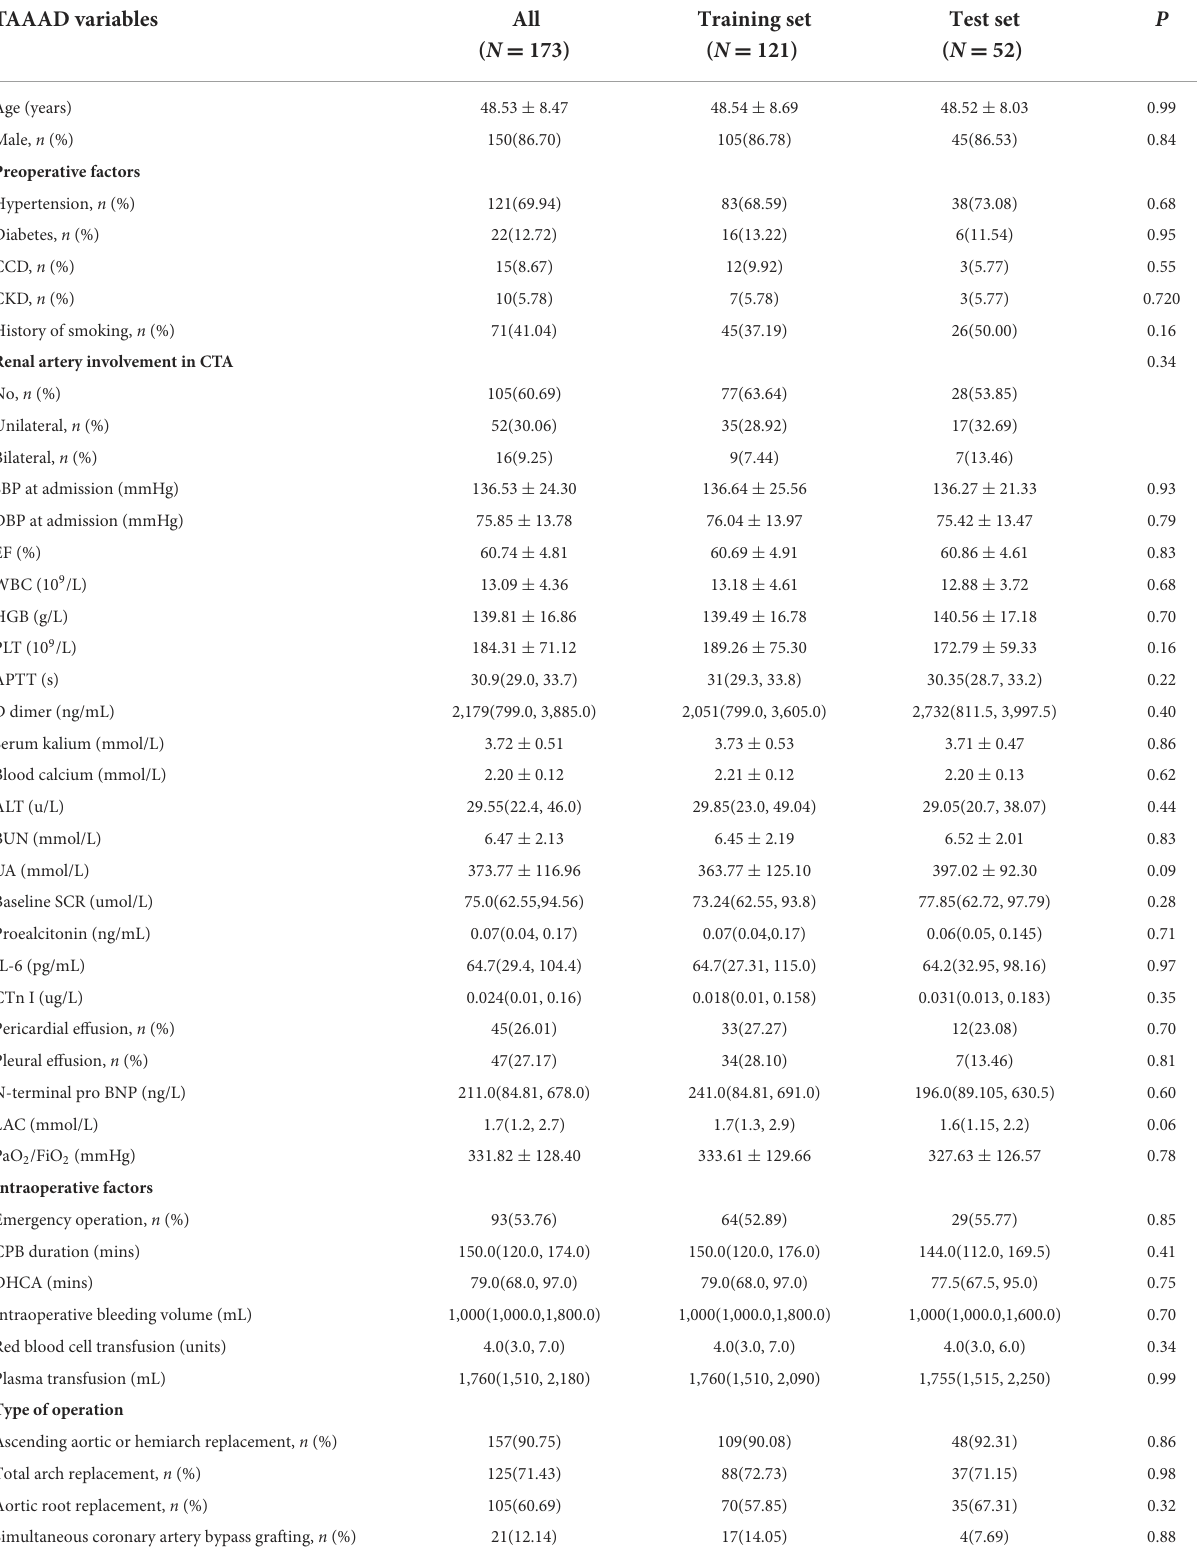
TABLE 1 TAAAD patient characteristics and perioperative